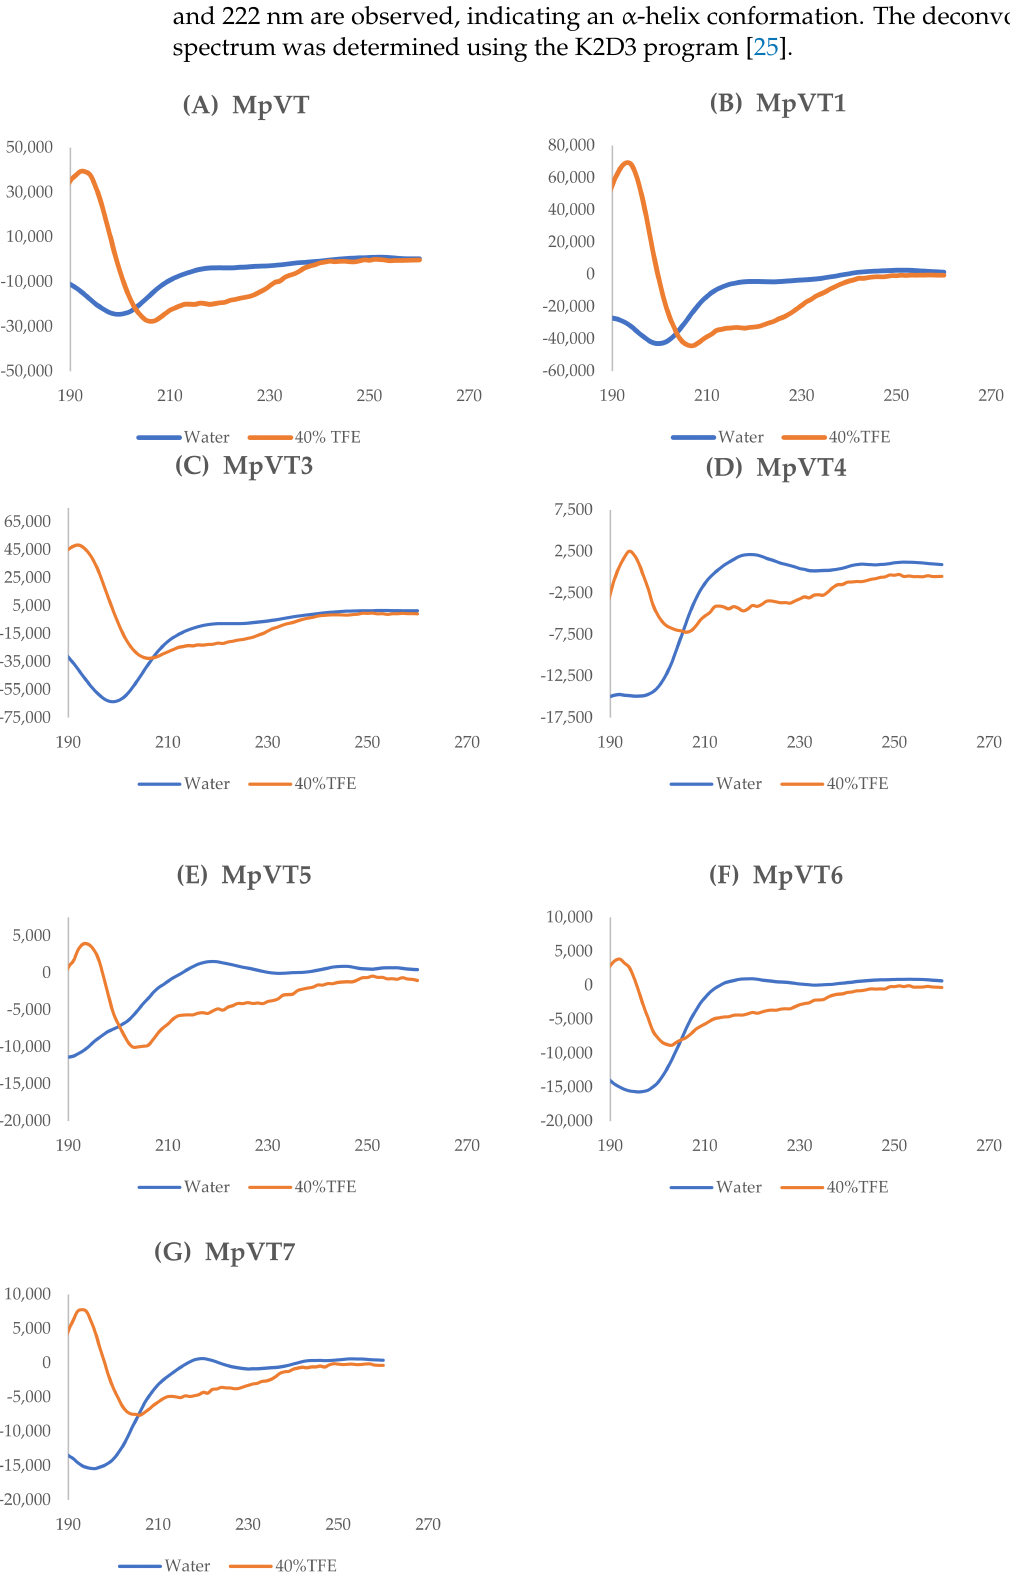
Figure 3. Circular dichroism (CD) spectra of MpVT and its analogs obtained at 100 µ g/mL peptide concentration at 25 ◦ C ( A – G ). All MpVTs showed unordered conformation in water (blue line) and characteristic α -helical spectra in the presence of 40% TFE (red